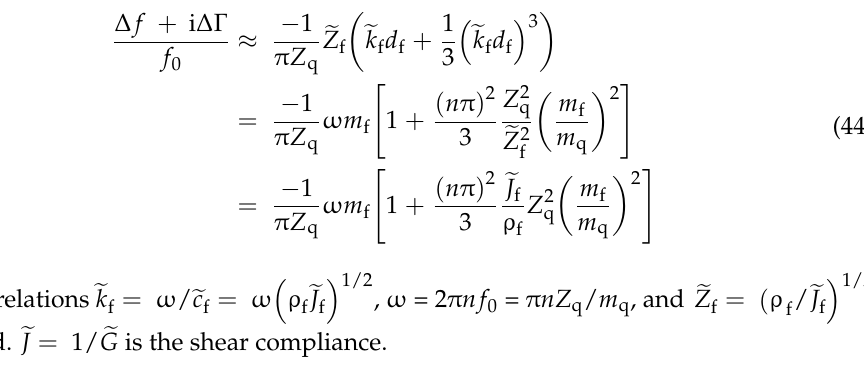
(cid:17) 1/2 (cid:16) ρ J f , ω = 2 π nf 0 = π nZ q / m q , and (cid:101) Z f = ( ρ f (cid:101)